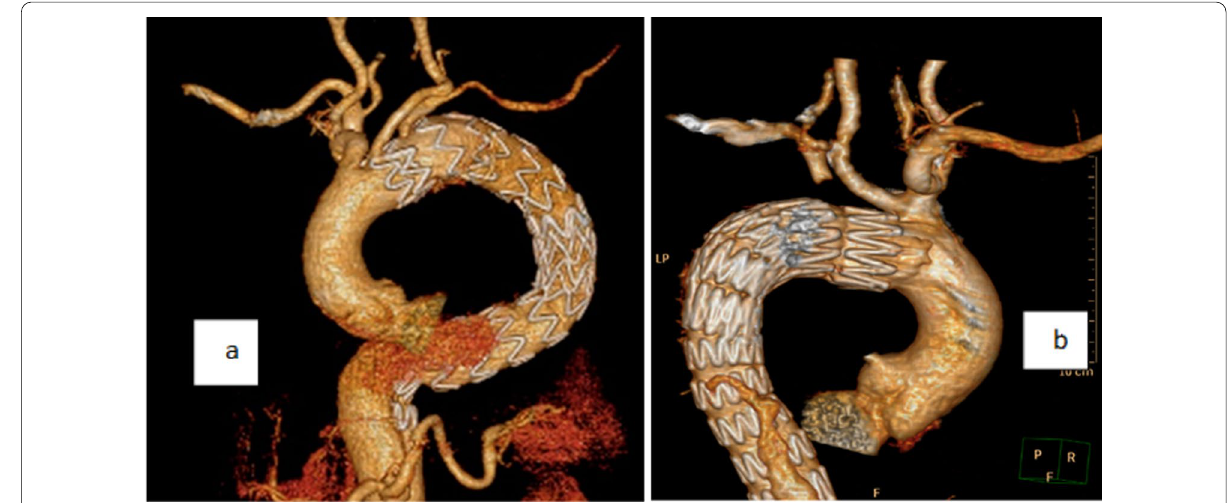
Fig. 2 6 months follow up showing the left subclavian covered with the endograft. a patient with two endografts. b Patient with three endograft, the origin of left subclavian was not visualized white arrow, c a patient with a single endograft, d a patient with two endografts with non‑visualization of the origin of the left subclavian